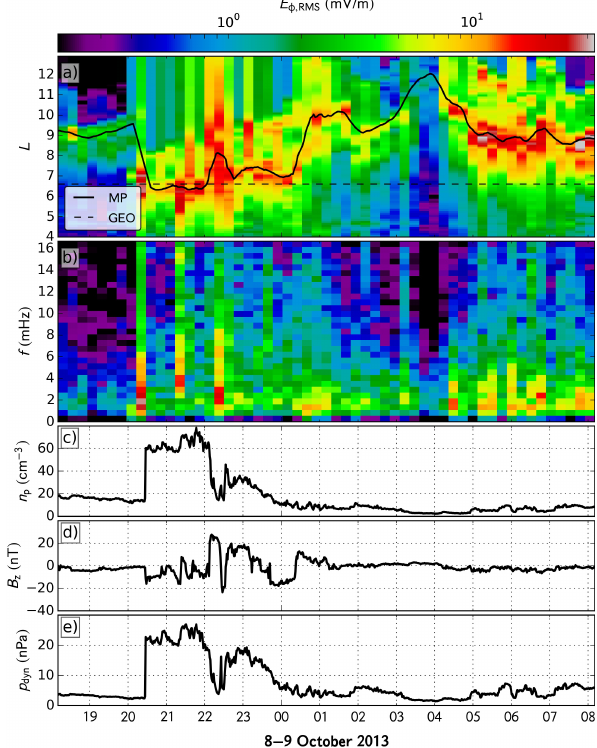
Figure 3. Power spectrum analysis for 8 October 2013 storm. The figure follows the same format as Fig. 1.